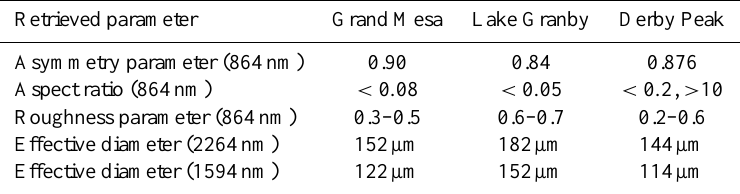
Table 1. List of ice crystals’ parameters retrieved for the three analyzed scenes. The value in parentheses indicates the RSP band used in the retrieval. The effective diameter can be obtained using either the 2264 or the 1594nm channel (see text), together with a crystal habit characterized by the asymmetry parameter retrieved for the corresponding